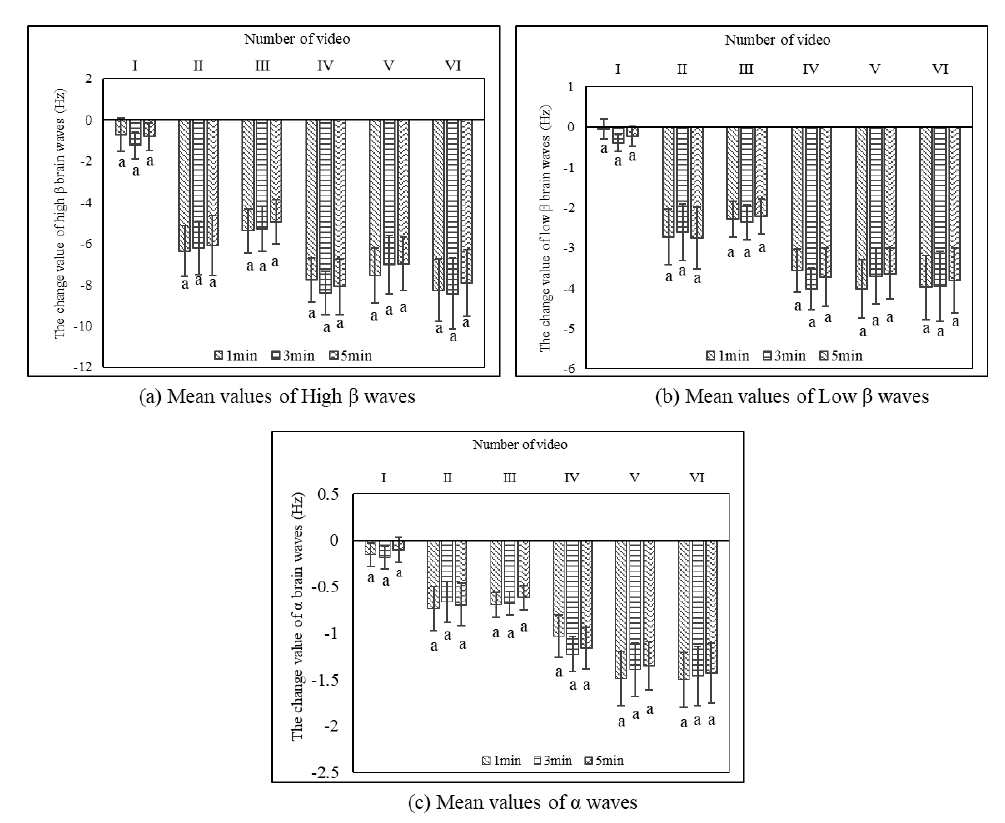
Figure 5. Changes in EEG mean values after watching the urban bamboo forest videos of different durations ( n = 30; mean ± standard error). The same lowercase letter “a” represents no significant differences between 1, 3, and 5 min with each video for the EEG indicators. The zero point represents the value measured after participants watched the blank video.